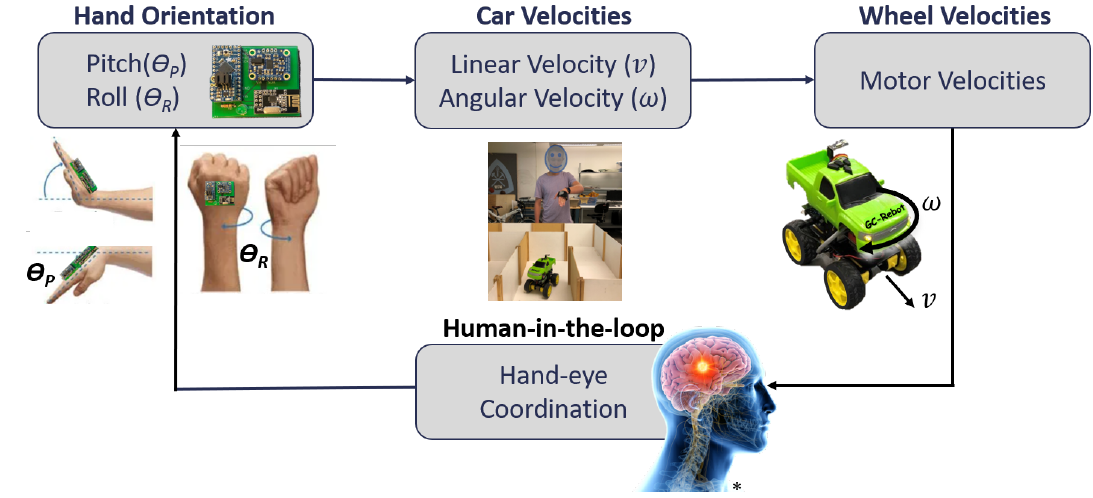
Figure 3. GC-Rebot system design schematic. Hand orientations are mapped to car velocities ( v , ω ) and converted to motor velocities for proportional open-loop motor control. Hand-eye coordinated movements close the control loop, providing feedback to the system through changes in wrist pitch and roll (* brain image courtesy of